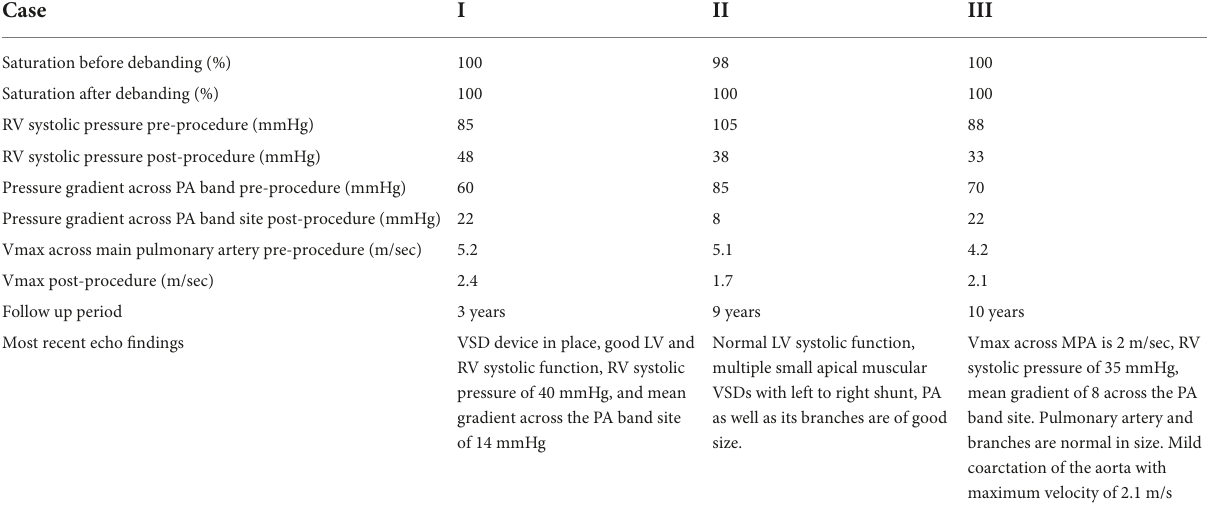
TABLE 2 Procedural details of the three patients who had undergone successful percutaneous PA band